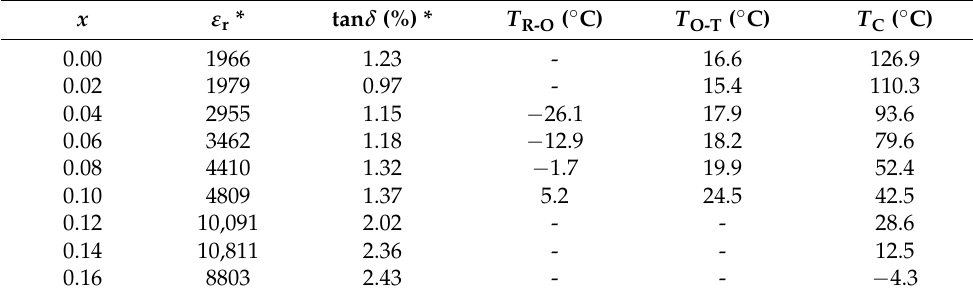
Table 1. Dielectric properties and phase transition temperatures of BT- x CS.